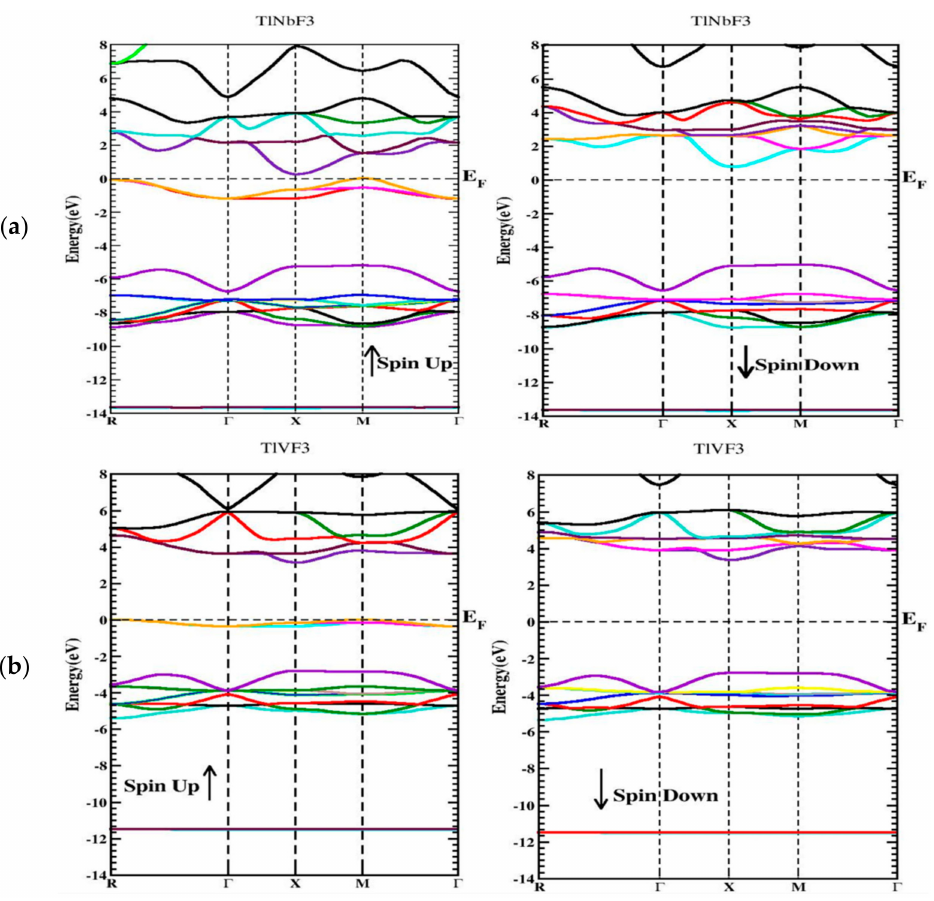
Figure 3. Band configurations of ( a ) TlNbF 3 ( b ) TlVF 3